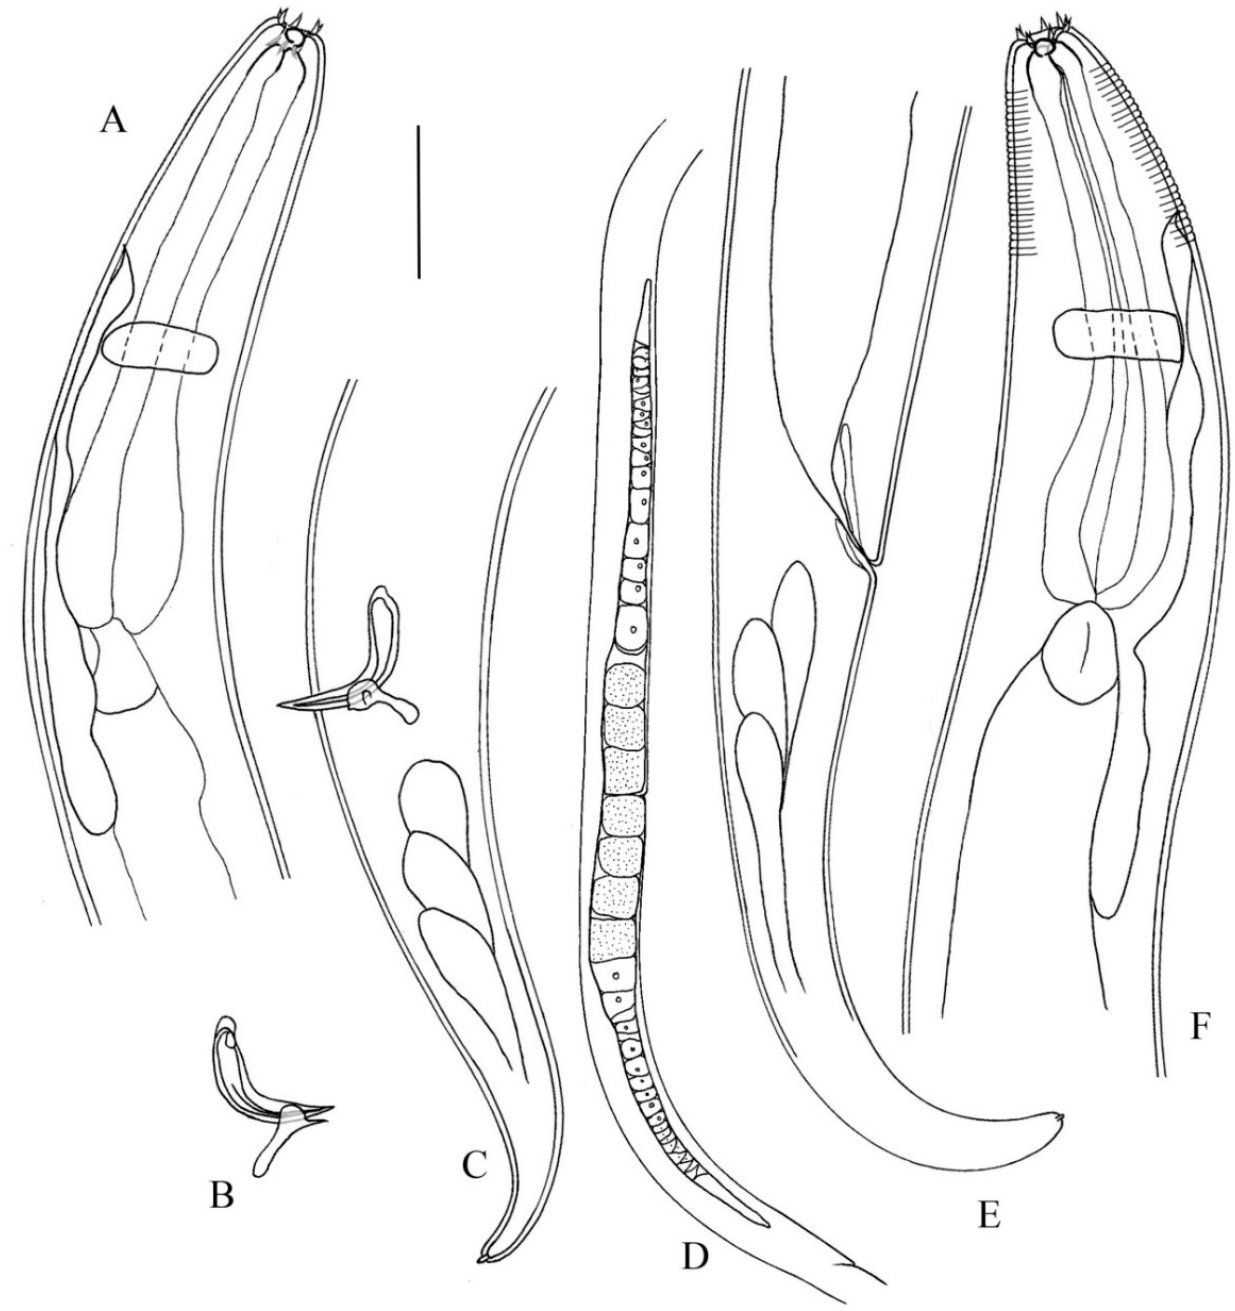
Figure 1. Anticyathus shenzhensis sp. nov.—holotype male and paratype female in lateral view. ( A ) lateral view of male head end; ( B ) lateral view of male copulatory apparatus; ( C ) lateral view of male tail region; ( D ) lateral view of female body part, showing ovaries; ( E ) lateral view of female tail region; ( F ) lateral view of female head end. Scale bar: ( A – C , E , F ) = 50 µm; ( D ) = 250 µm.